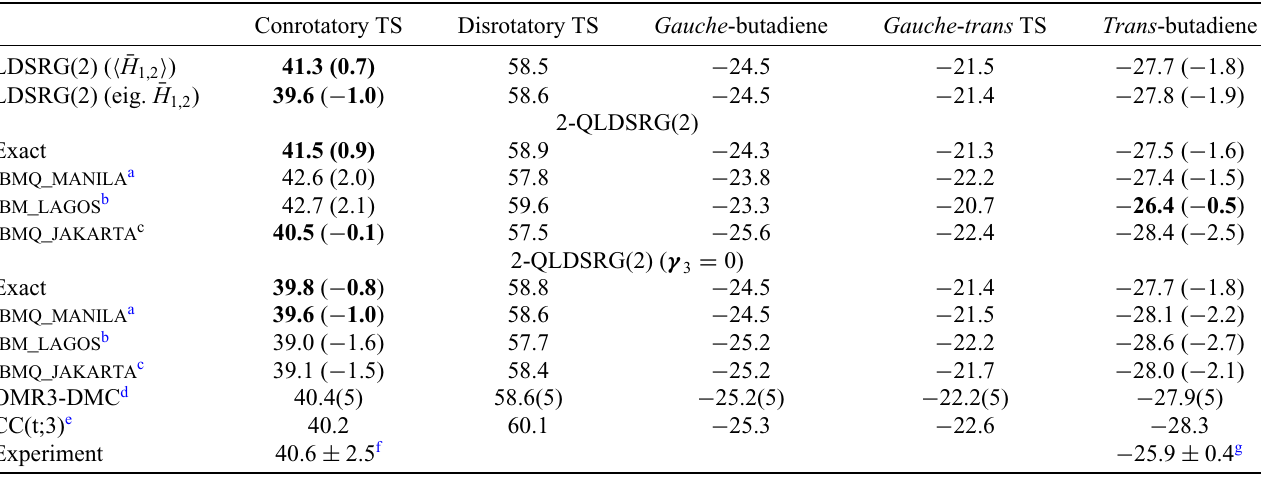
TABLE V. LDSRG(2) and QLDSRG(2) (exact and device) computations of the relative enthalpies (in kcal mol − 1 ) with respect to the bicyclobutane reactant of the conrotatory transition state and the disrotatory transition state, the gauche -butadiene intermediate, the transition state connecting gauche -butadiene and trans -butadiene, and the trans -butadiene product. We use the cc-pVTZ basis [85] (204 basis functions) and CASSCF(2,2) natural orbitals and the flow parameter value s = 1.0 E − 2 . All results include zero-point h vibrational energy (ZPVE) corrections taken from Ref. [118]. The OMR3-DMC and CC(t;3) results also use the cc-pVTZ basis. The differences of values (in kcal mol − 1 ) with respect to the experimental data for the conrotatory transition state and trans -butadiene are shown in parentheses; values within 1 kcal mol − 1 deviation are indicated in bold type. Conrotatory TS Disrotatory TS Gauche -butadiene Gauche - trans TS Trans -butadiene LDSRG(2) ( (cid:8) ¯ H 1,2 (cid:9)